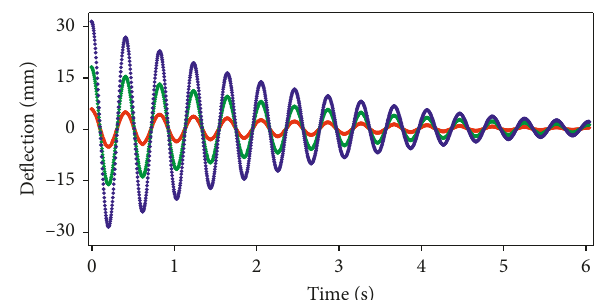
Figure 7: Empirical deflection of the system measured by sensors S